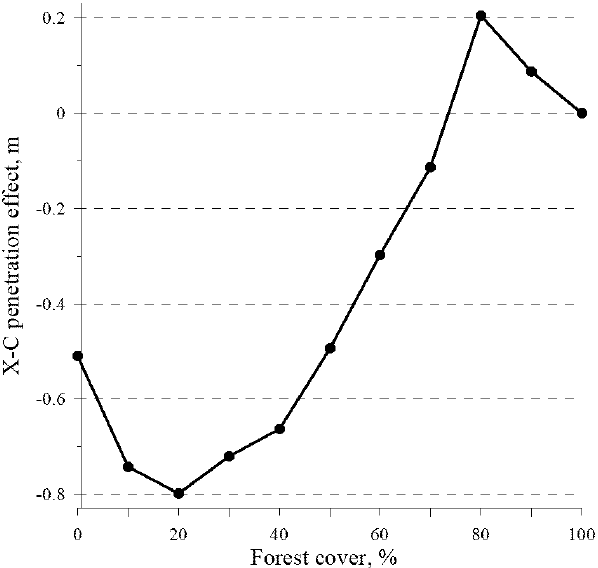
Figure 3. The effect of forest cover on the penetration difference between the X- and C-band SRTM DEMs.